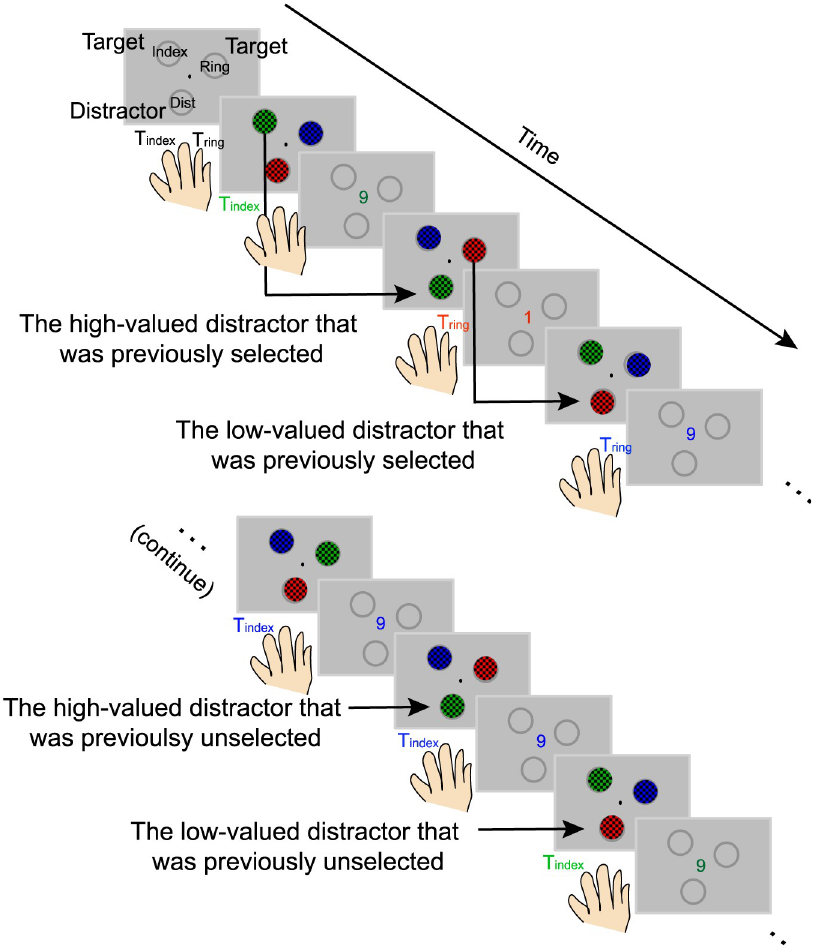
Fig 1. Value-based decision-making task. Participants selected 1 of the 2 target stimuli to learn values associated with their colors while ignoring a task-irrelevant distractor that could never be selected and was thus unactionable. Across trials, the colors of the targets and the distractor changed randomly so that the distractor color on a given trial could match the color of a previously selected target that yielded either a low or a high monetary reward (i.e., low- or high- valued